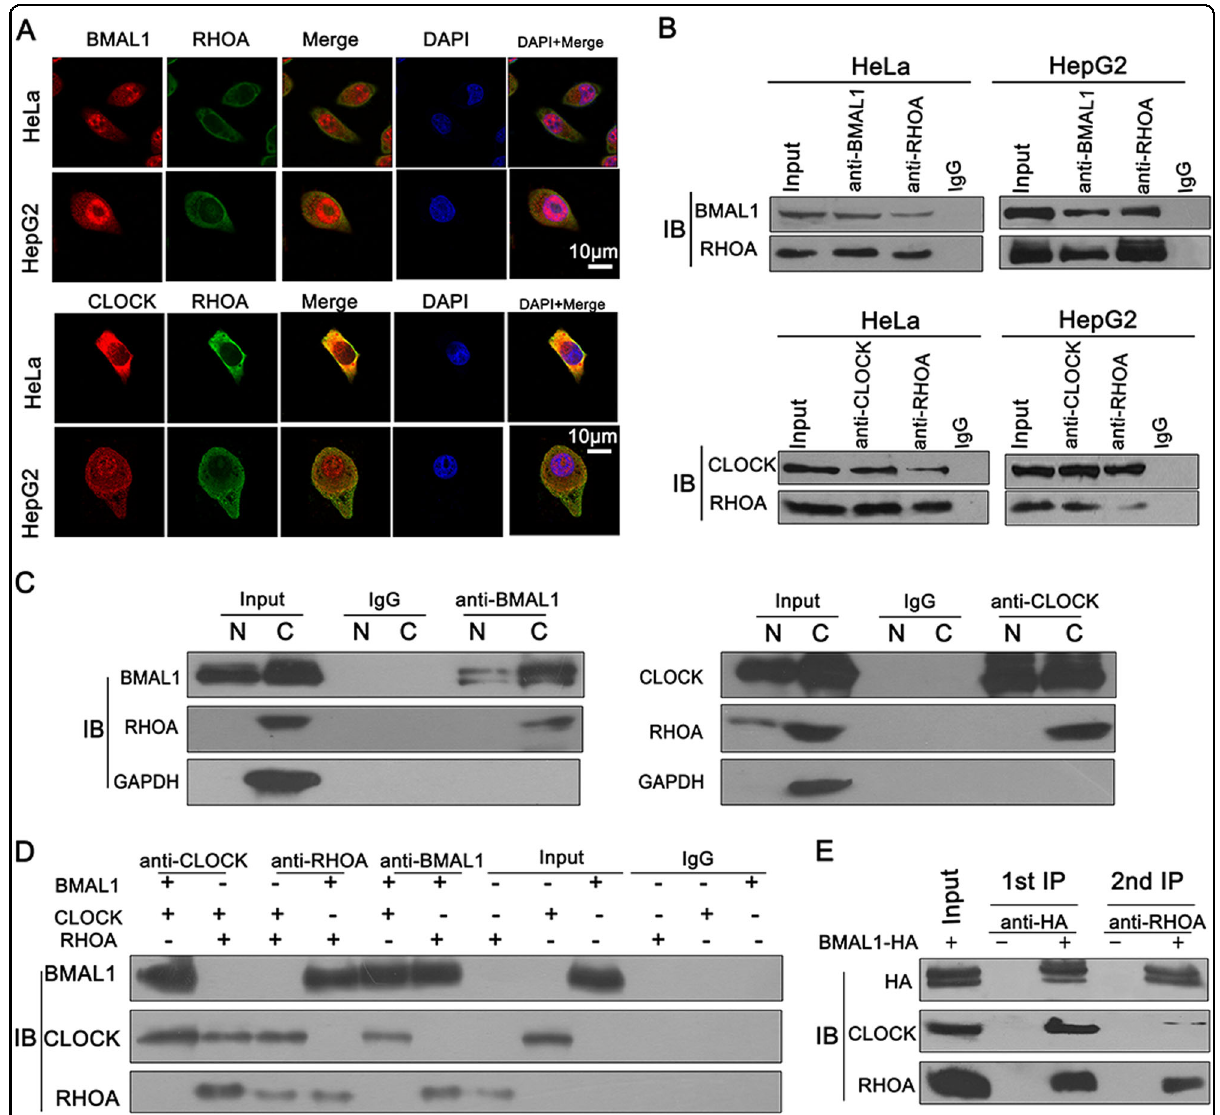
Fig. 2 CLOCK and BMAL1 interact with RHOA. a Immuno fl uorescent staining of endogenous BMAL1/CLOCK (red) and RHOA (green) in HeLa and HepG2 cells. Blue color represents the nucleus stained with DAPI. The scale bars represent 10 μ m. b The complex was immunoprecipitated from total protein extracts collected from HeLa and HepG2 cells. The immunoprecipitates were analyzed by western blot with antibodies against BMAL1, CLOCK, or RHOA. c Cytosolic (C) and nuclear (N) fractionation followed by Co-IP were performed in HeLa cells. d The TNT ® Quick Coupled Transcription/Translation System was used for protein expression in vitro. The synthesized proteins were then analyzed by Co-IP with antibodies against BMAL1, CLOCK, or RHOA. e Two-step IP assay. Cell lysates were immunoprecipitated with the anti-HA antibody, and then BMAL1-HA and the associated proteins were eluted with 4 × HA peptide (30 μ mol/ μ